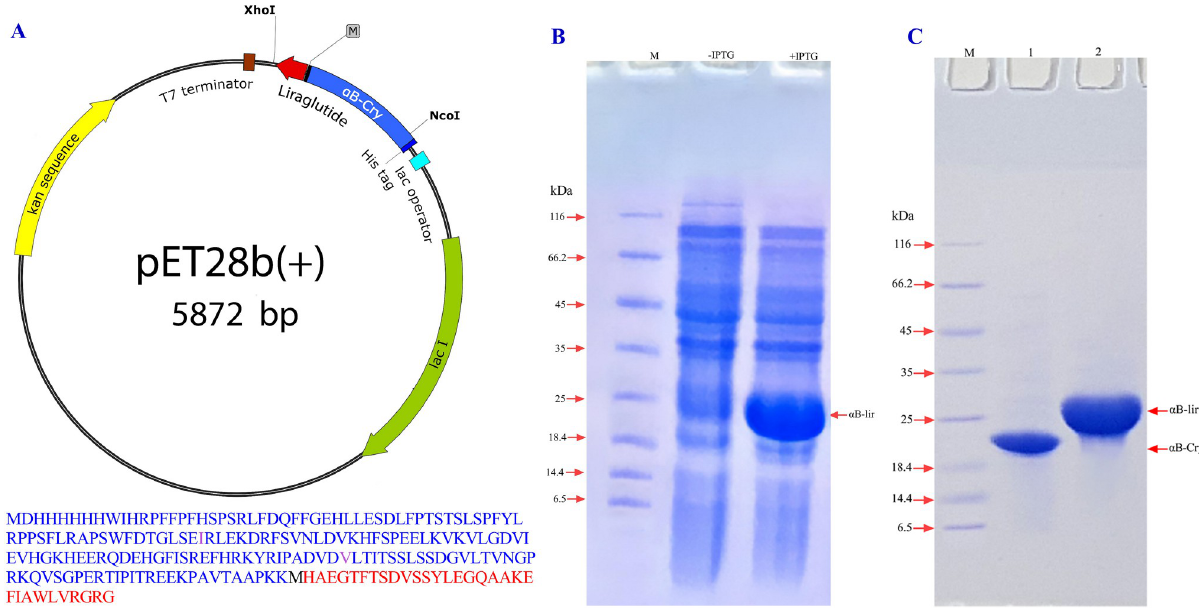
Fig 1. From designing the gene construct to the expression and purification of α B-lir hybrid protein. A ) pET28b(+) vectors containing the hybrid gene ( α B-lir) are demonstrated. The positions of NcoI and XhoI restriction sites are also indicated. The translation frame on this vector shows the amino acid sequence of α B-lir hybrid protein. The human α B-Cry gene is portrayed in purple, and the primary structure of the LPP is shown as red. Also, M stands for the methionine residue that provides a CNBr specific cleavage site. In the primary structure of the human α B-Cry gene, methionine 68 and proline 130 are substituted with isoleucine and valine residues, respectively. B ) The expression of α B-lir hybrid protein was assessed by SDS-PAGE analysis (gel 12%). The α B-lir expression in the absence and presence of 0.25 mM IPTG is indicated, and M shows the protein mass markers. C ) The α B-lir was purified using the precipitation method followed by a DEAE column. Then, the pure α B-lir was analyzed on a reducing SDS-PAGE (gel 12%). Lanes 1 and 2 stand for human α B-Cry and α B-lir hybrid protein, respectively. Also, M indicated the protein mass marker.